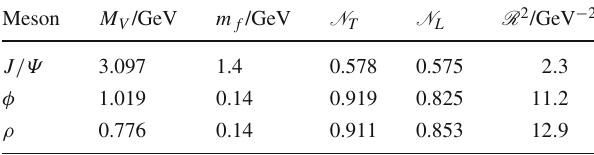
Table 1 Parameters of the “boosted Gaussian” vector meson wave